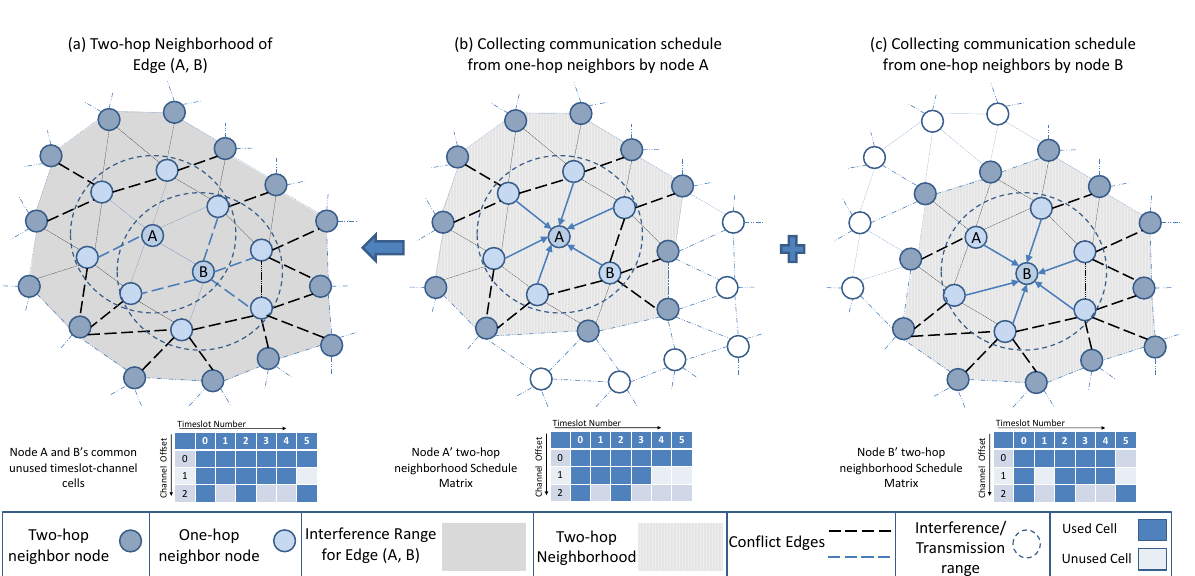
Figure 8. Selecting an interference-free cell on ( a ) edge (A, B) based on the constructed schedule-matrix of ( b ) node A and ( c ) node